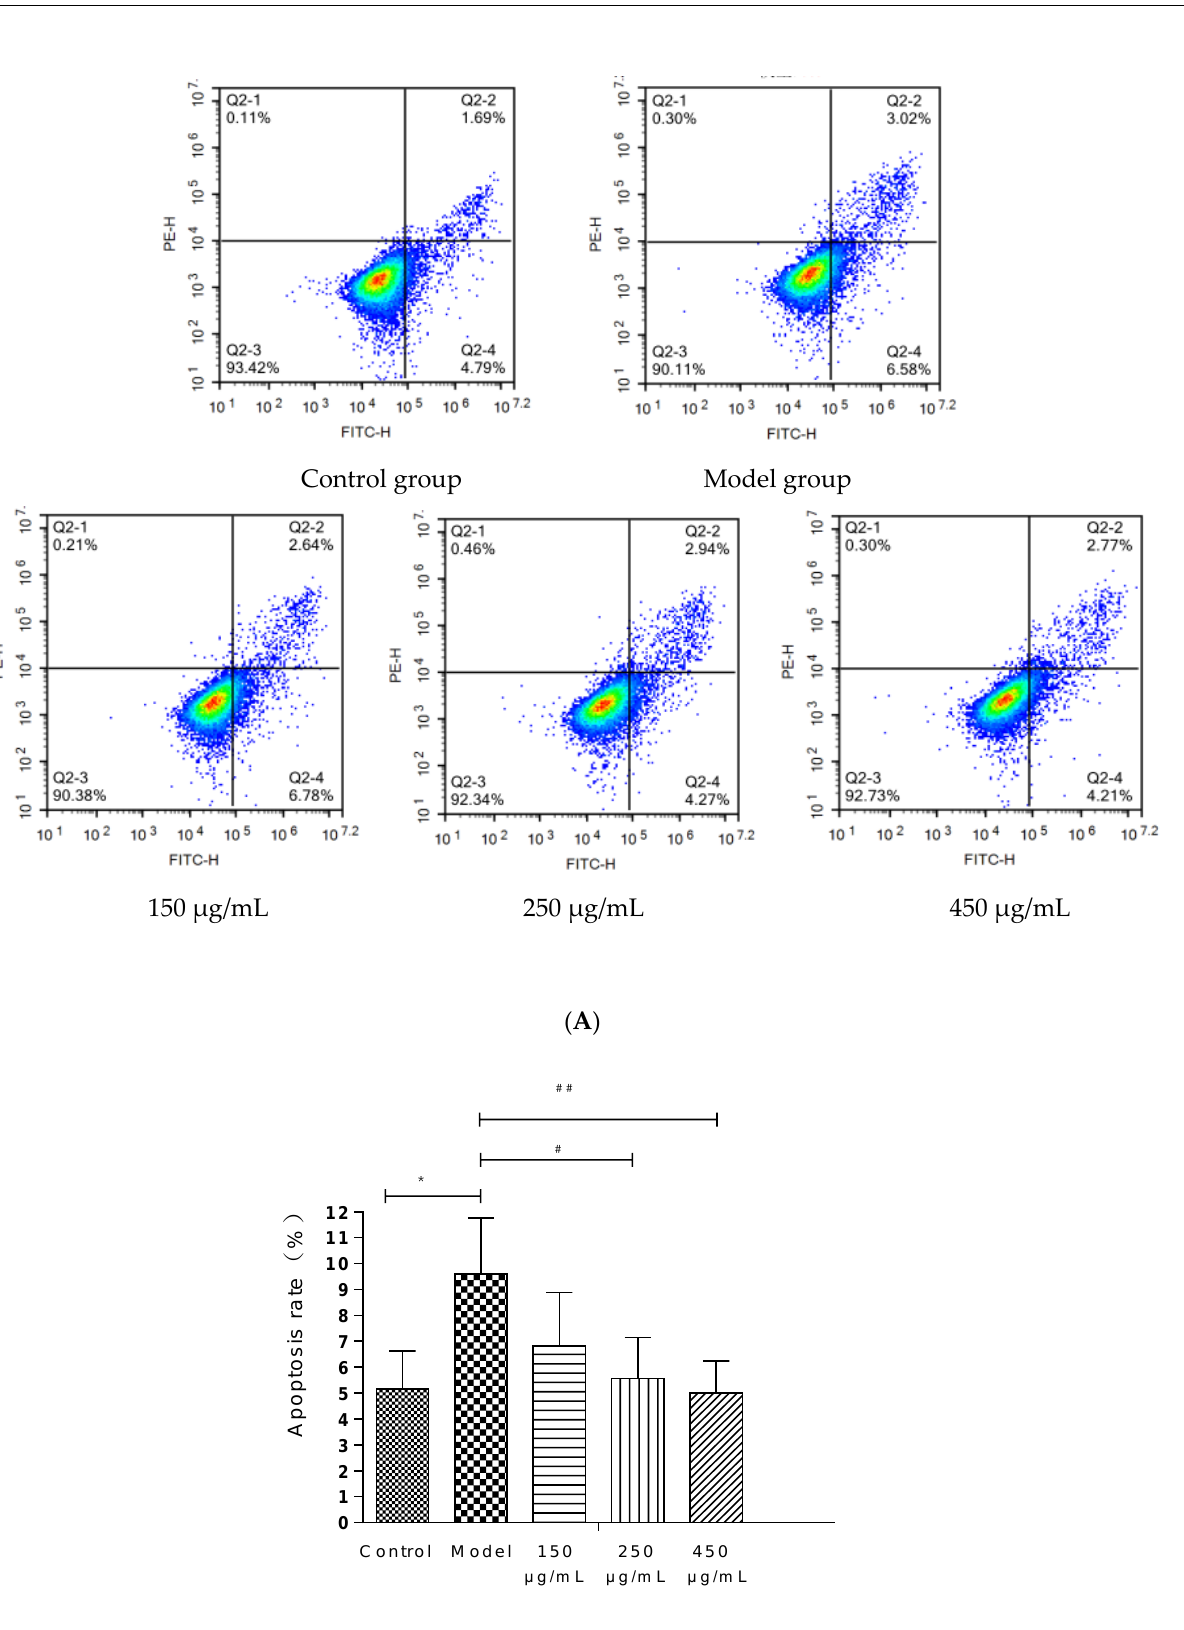
Figure 5. Annexin V-FITC Apoptosis Detection by Flow Cytometry in HepG2 cells ( A , B ). Values are the mean ± standard deviation. Compared with control: *, p < 0.05. Compared with model: # , p < 0.05, ## , p < 0.01.